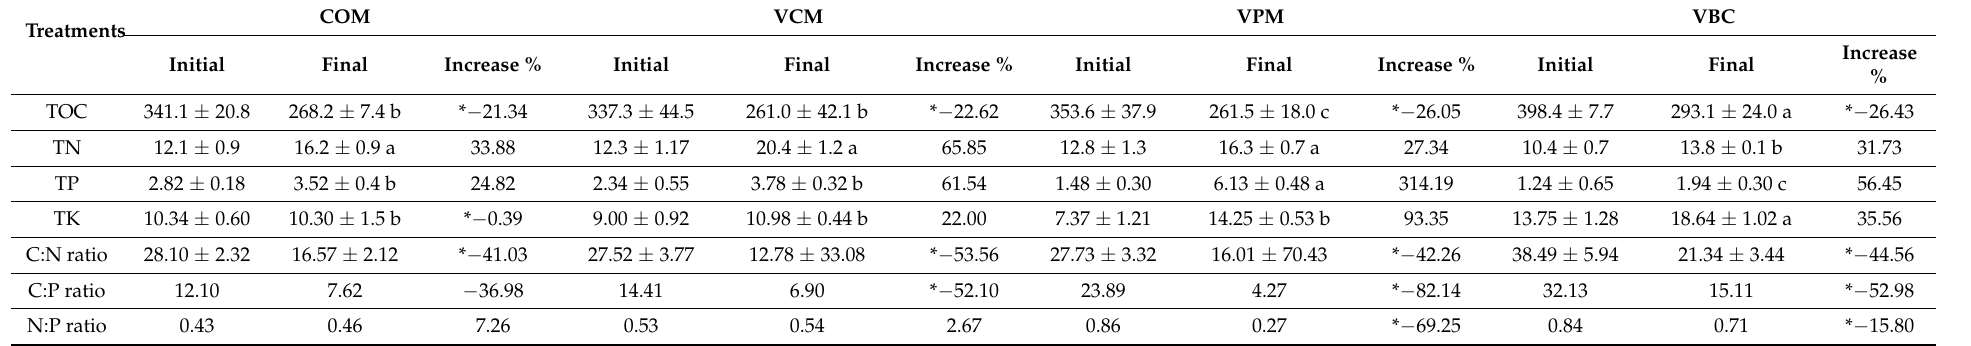
Table 2. Nutrient (g/kg) change during